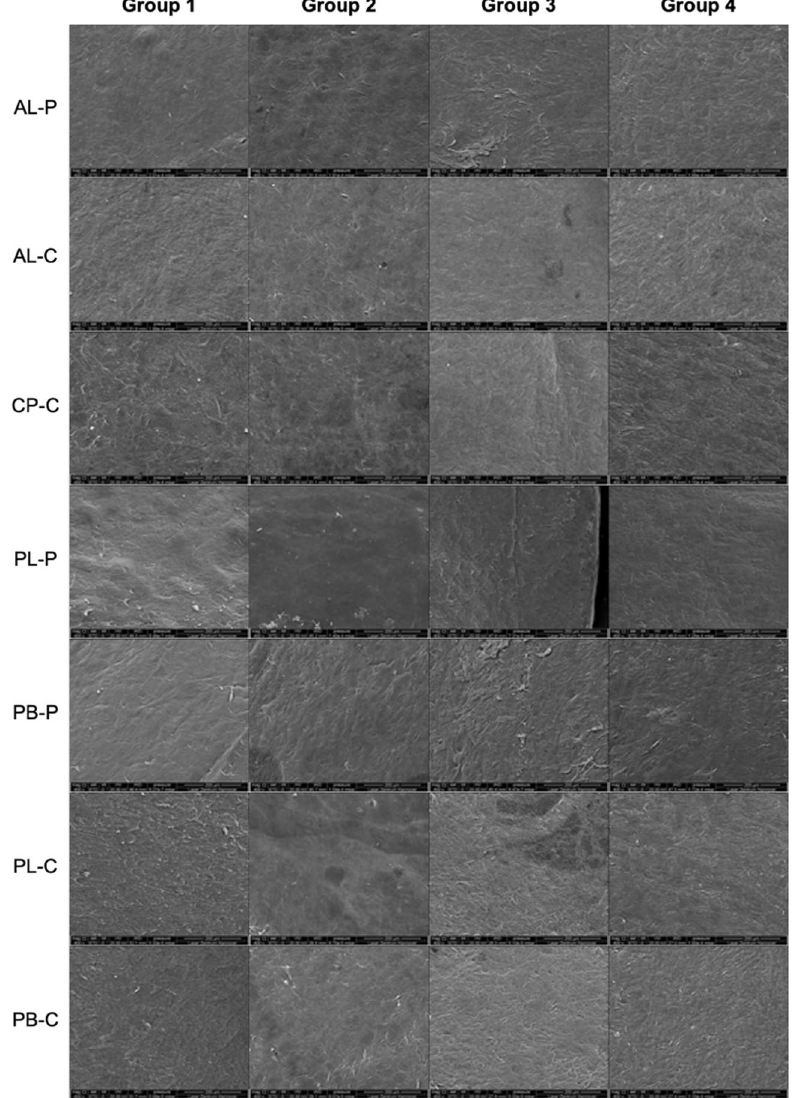
Figure 3. Example SEM pictures at X400 magnification for scans at different locations in group 1 (laser power:32% for − 2.0D treatment), group 2 (laser power:64% for − 2.0D treatment), group 3 (laser power:32% for − 5.0D treatment) and group 4 (laser power:64% for − 5.0D treatment). The pictures show the scans of anterior lenticular surface periphery & centre, anterior cap centre, posterior lenticular periphery & centre and posterior stromal base centre and periphery. (AL-P = anterior lenticule surface periphery; AL-C = anterior lenticule surface centre; CP-C = Centre of cap’s posterior surface; PL-P = posterior lenticule surface periphery; PB-P = posterior stroma base periphery; PL-C = posterior lenticule surface centre; PB-C = posterior stroma base